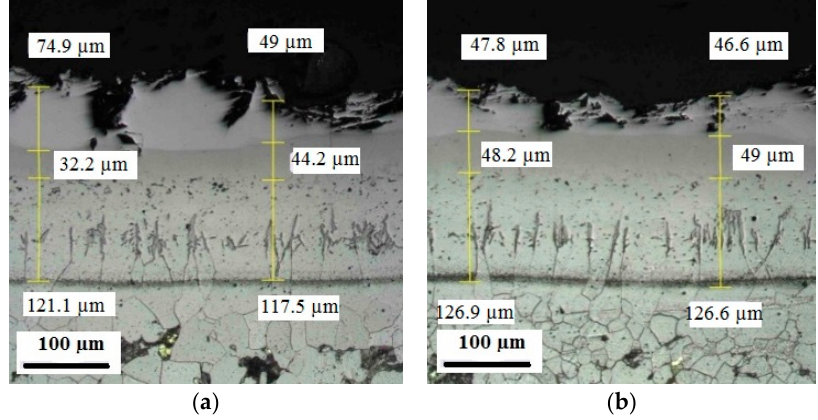
Figure A8. Microscopic images of the cross-section of CS-A-Sn ( a ) before and ( b ) after the low-temperature corrosive attack after 168 h.